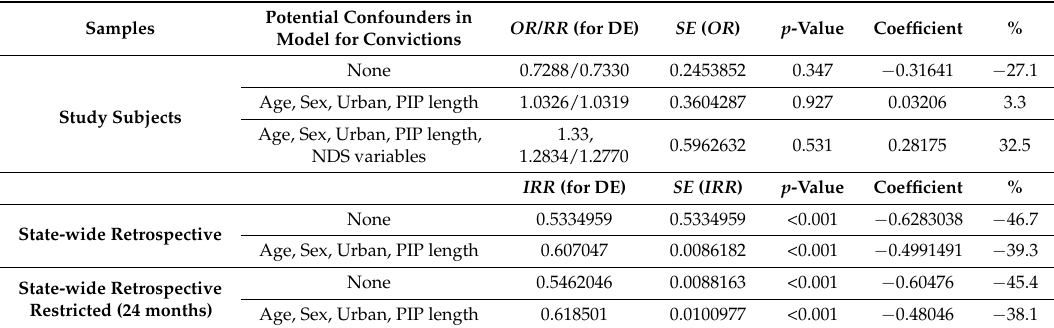
Table 6. Influence of Confounding Factors on